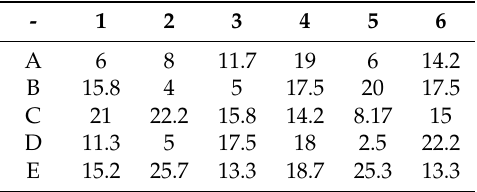
Table 8. The distance (km) from locations to fields.